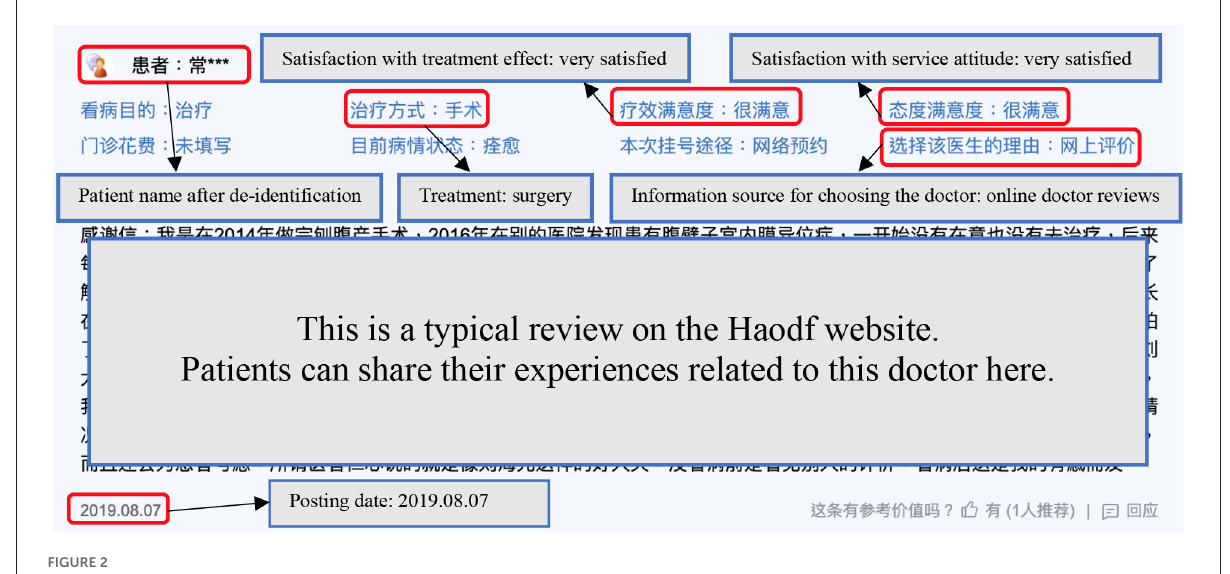
FIGURE2 An example of an online doctor